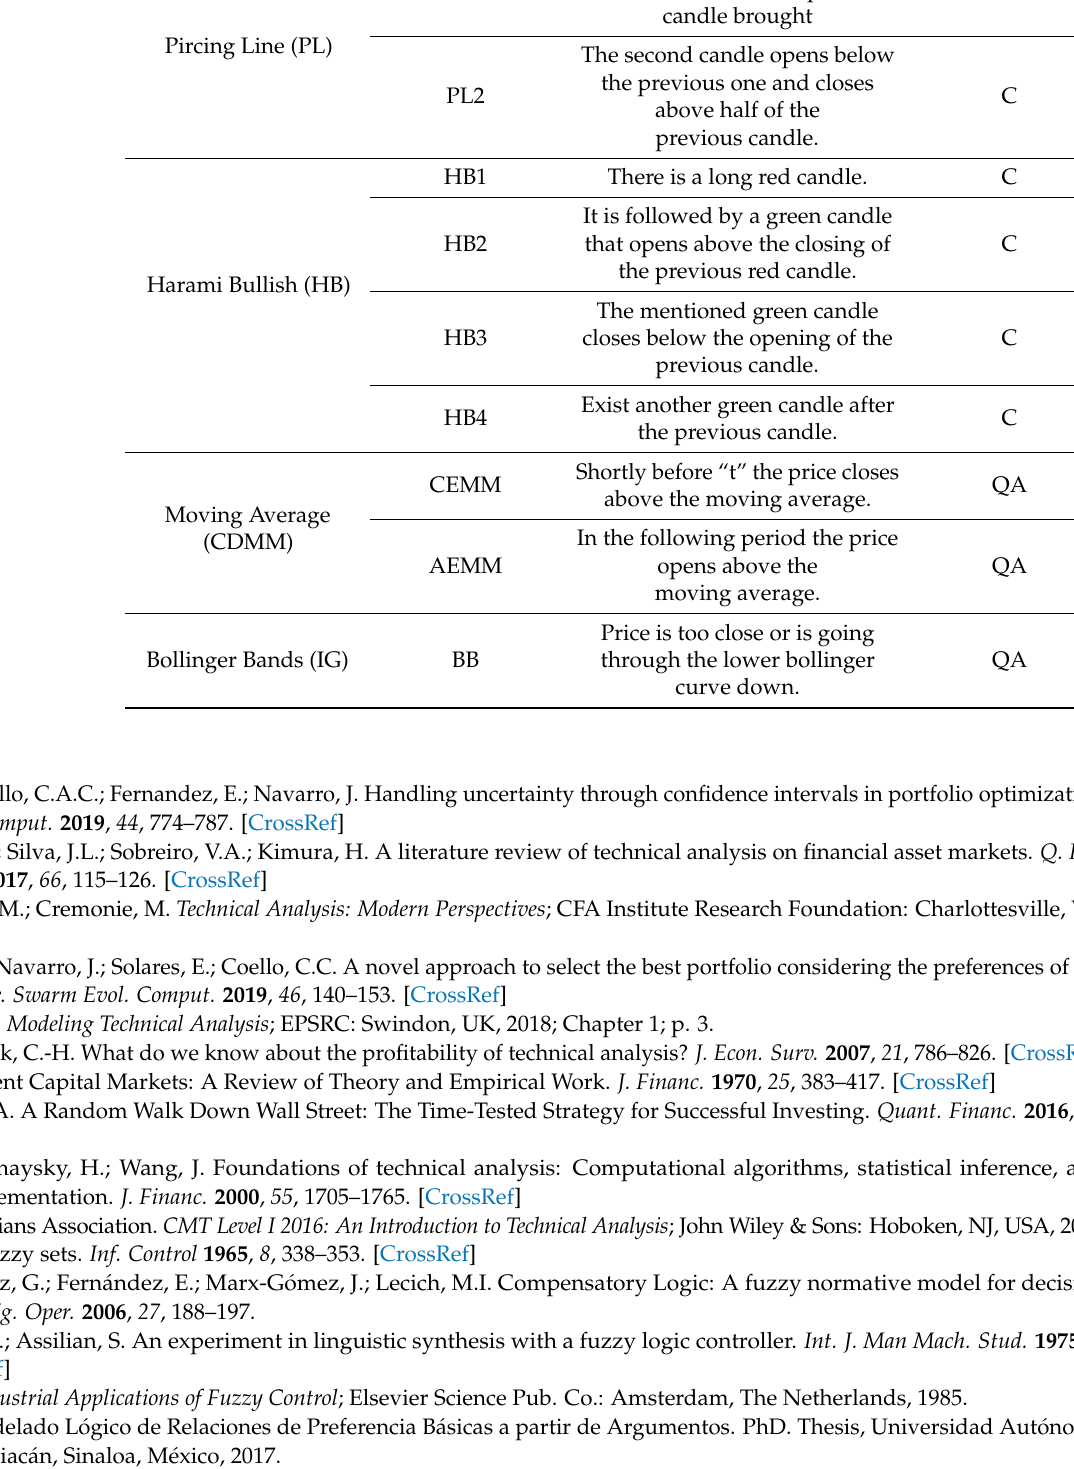
Table A2. Cont. Rule Predicate Pircing Line (PL)